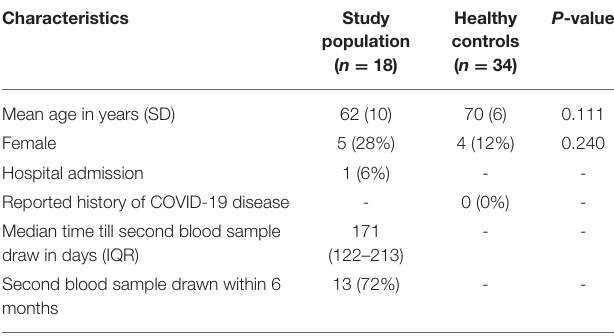
TABLE 1 | Baseline characteristics of study population and healthy controls. Characteristics